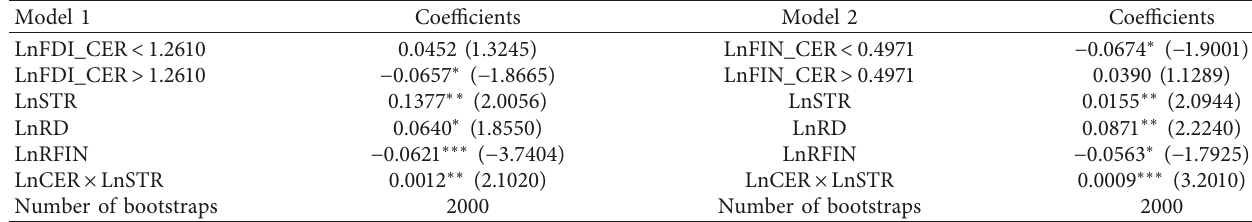
Table 6: Impact of command-and-control environmental regulation on the TFP.